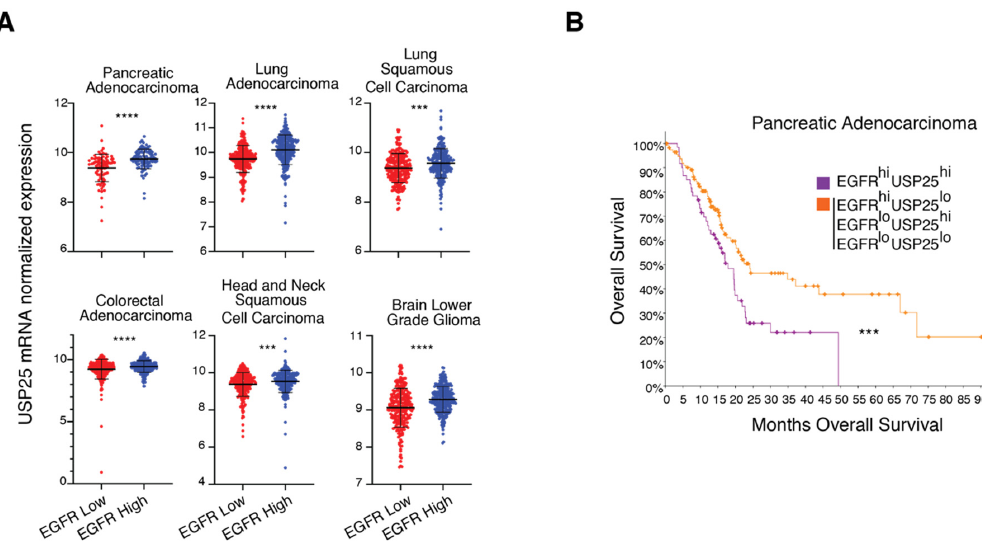
Figure 6. High levels of USP25 correlate with EGFR expression and induce a worse overall survival in cancer patients. ( A ) Scatter dot plot of USP25 mRNA expression in cancer patients with high (blue) or low (red) EGFR mRNA expression. Patient samples were classified as EGFR high if their normalized EGFR mRNA expression value was higher than the median value. The following cancer types were analyzed: colorectal adenocarcinoma (N = 592), lung adenocarcinoma (N = 510), lung squamous cell carcinoma (N = 488), pancreatic adenocarcinoma (N = 177), head and neck squamous cell carcinoma (N = 515), and brain lower grade glioma (N = 514). **** q -value < 0.0001, *** q -value < 0.001 by Benjamini–Hochberg procedure. ( B ) Kaplan–Meier curve of overall survival for pancreatic adenocarcinoma patients according to their EGFR and USP25 mRNA expression. Patient samples were classified as EGFR high (or USP25 high) if their normalized mRNA levels were higher than the median value. Patients with both EGFR high and USP25 high expression were clustered together (purple) and overall survival was compared with that of all the other patients